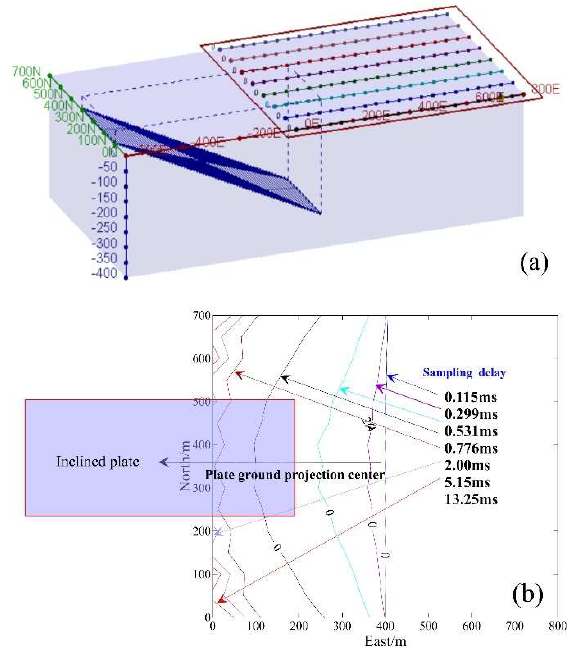
Figure 4. 3D forward models for fixed-loop and X-component characteristic curves: ( a ) 3D forward model; ( b ) relative position of the plate and the X-component zero contour.